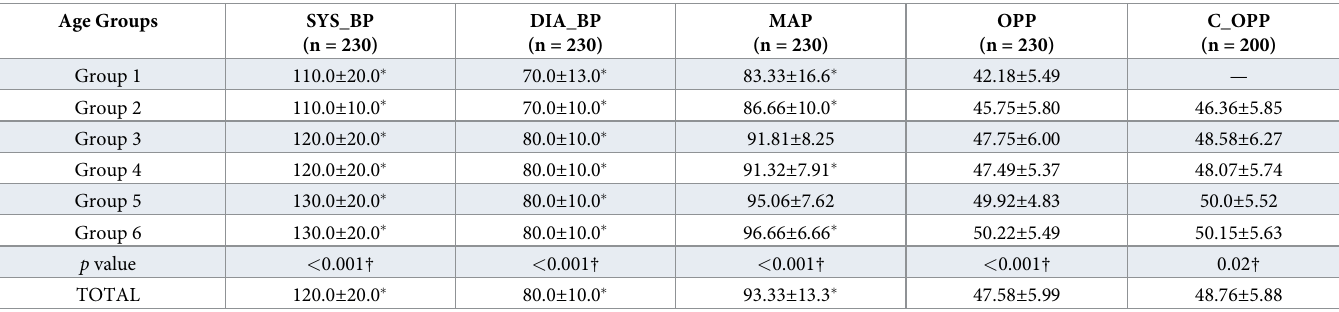
Table 2. Choroidal thickness in normal Indian subjects using SS-OCT: Details of systemic parameters in different age groups. Age